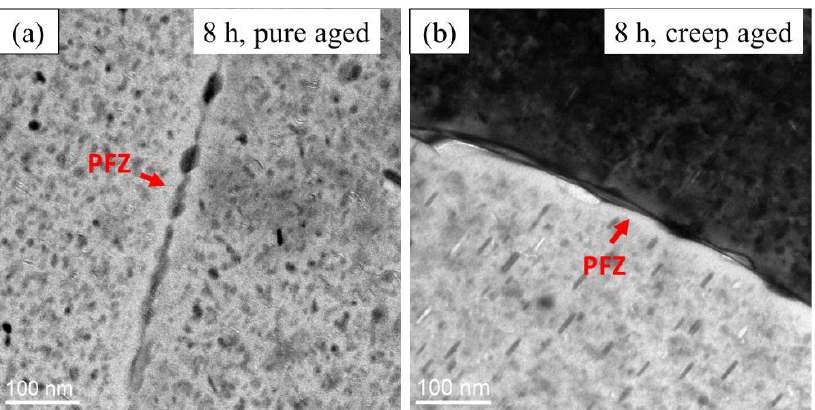
Figure 12. TEM micrographs showing the grain boundary and its corresponding precipitate free zone (PFZ) in the specimens after 6 h of ( a ) pure ageing; ( b ) creep ageing.